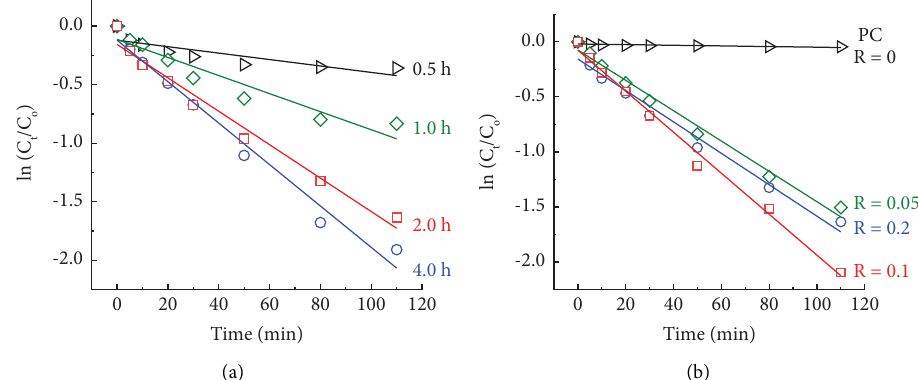
Figure 16: Pseudo-frst-order kinetics of AY23 decolorization with MPC catalysts prepared from (a) diferent pyrolysis time and (b) diferent FeCl 3 /NF mass